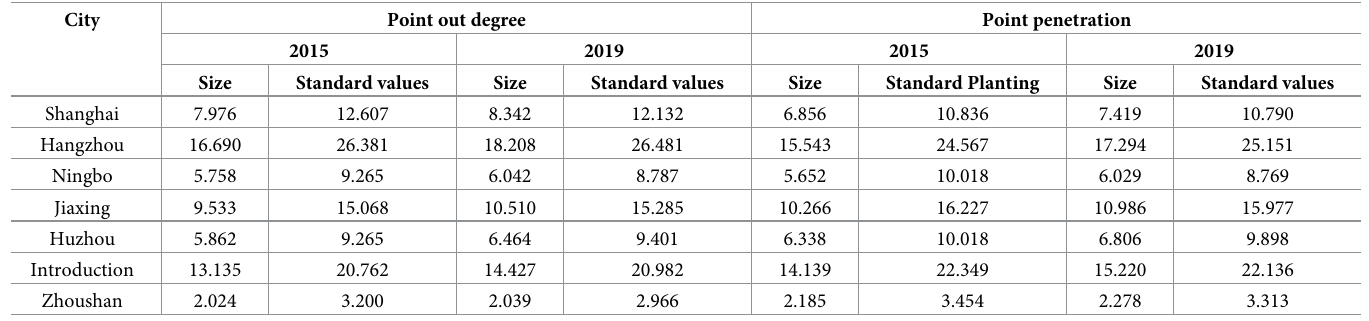
Table 2. Centrality of the business credit linkage network in the Hangzhou Bay Greater Bay Area.